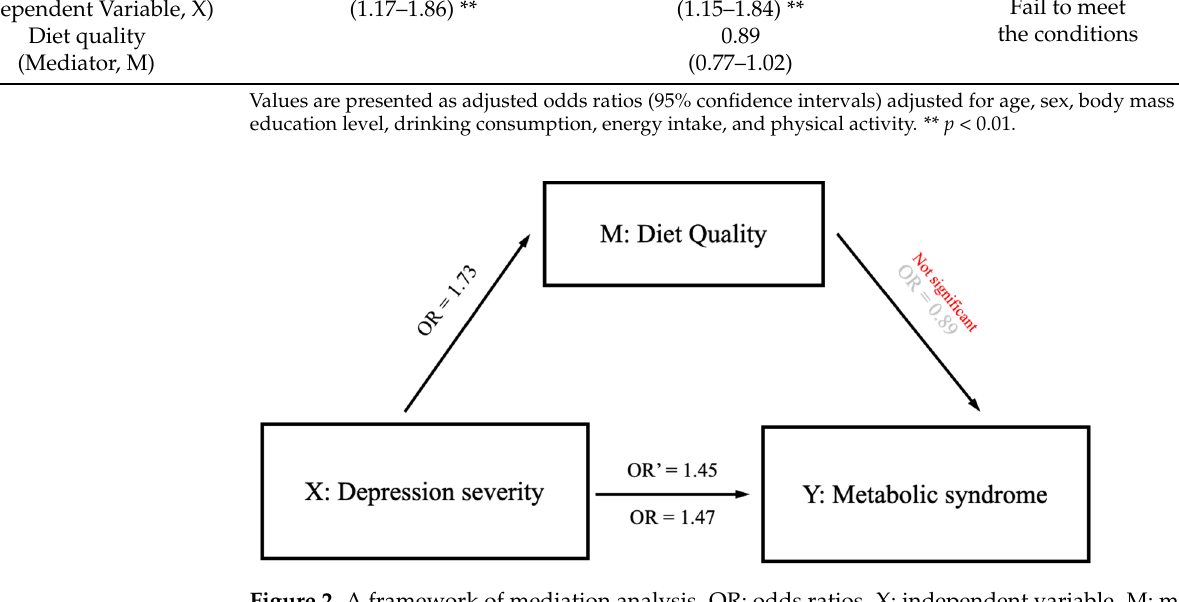
Figure 2. A framework of mediation analysis. OR: odds ratios. X: independent variable. M: mediating variable. Table 9. The mediating effect of diet quality on the association between depression severity and metabolic syndrome.